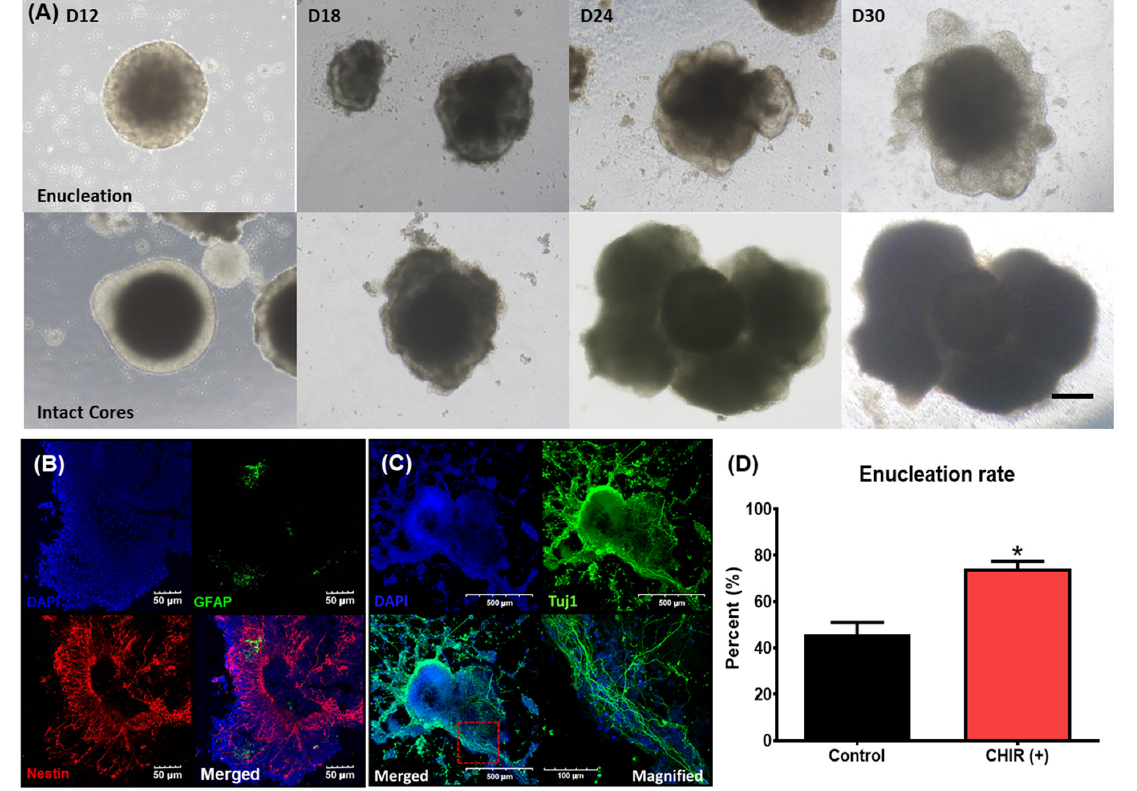
Figure 3. Different fates of EBs (with or without cores) and the effect of a Wnt agonist on enucleation. ( A ) Serial changes in two representative EBs from day 12 (D12) to day 30 (D30). The upper section shows the maturation of EBs after core enucleation. After core enucleation, protrusions around the surface started to develop and form otic organoids. The lower section shows the maturation of EBs with an intact core. These EBs gradually increased in size and developed into cell-rich organoids with multiple lobular projections. The scale bar in image ( A ) indicates 200 µm. Epifluorescence images of fully differentiated EBs (day 30) that did not undergo enucleation are shown in ( B , C ). ( B ) The distribution of GFAP- and nestin-positive cells throughout the whole organoid, suggesting that these organoids may have been neural structures. ( C ) Tuj-positive linear structures indicative of nerve fiber sprouting. The magnified image shows multiple linear structures spreading in the same direction. The scale bars in images ( B , C ) indicate different lengths. The application of CHIR, which is a Wnt agonist, altered the rate of enucleation. CHIR-treated EBs showed a higher rate of enucleation compared to control (no CHIR) EBs ( D ). (* p < 0.05).